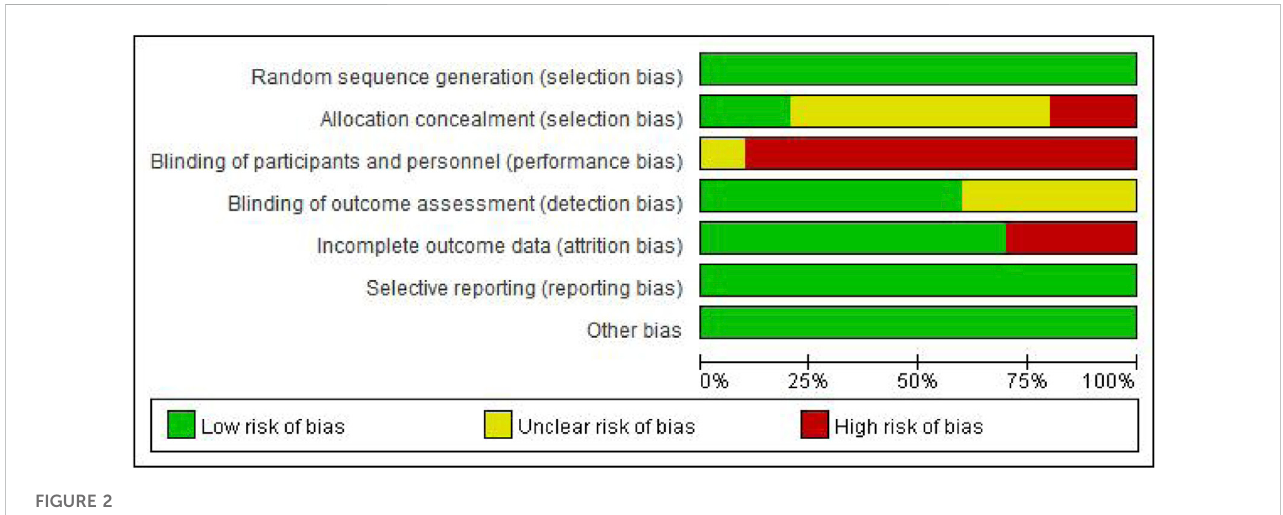
FIGURE 2 Schematic diagram of risk bias.